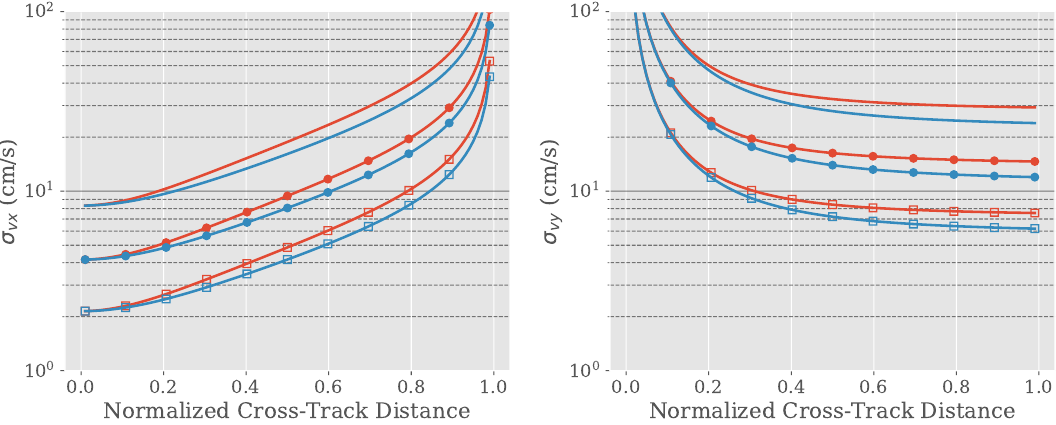
Figure 13. Expected surface velocity standard deviation as a function of normalized cross-track distance from nadir for the along-track ( left ) and cross-track ( right ) surface velocity components for antenna lengths, L , of 4m (red) and 5m (blue) and for peak output power of 100W (no marker), 400 W (filled circles), 1.5kW (empty